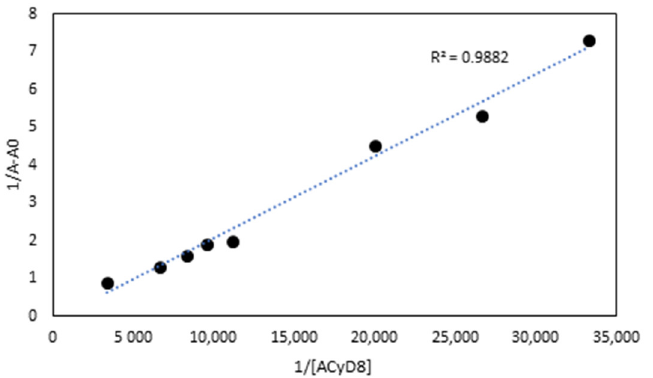
Figure 3. The Benesi–Hildebrand plot of 1/A-A 0 vs. 1/[ACyD8] obtained from UV-vis data.